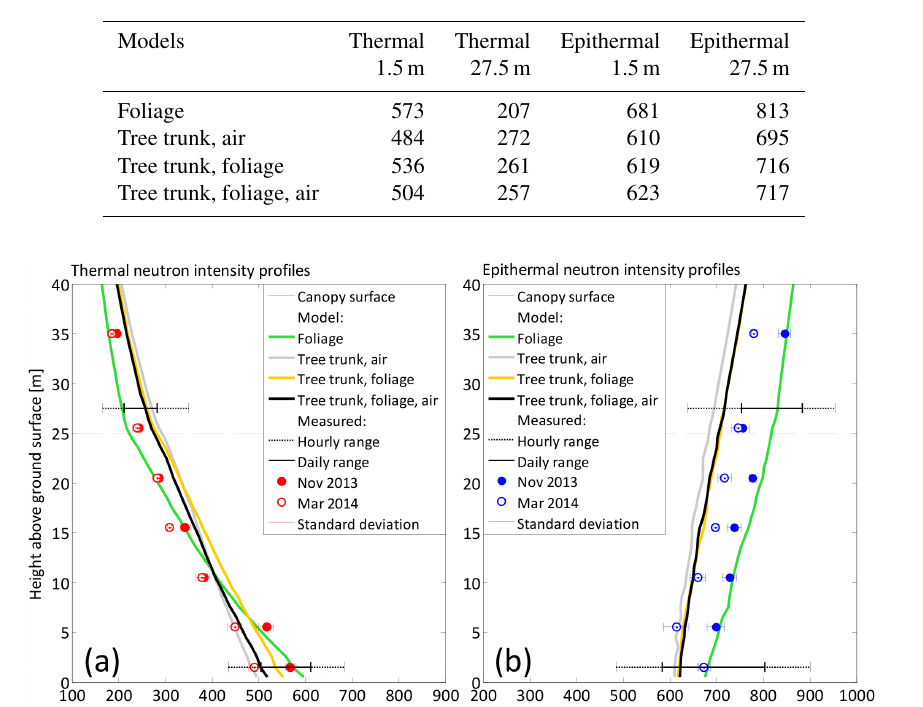
Table 5. Modeled ground level (1.5m) and canopy-level (27.5m) thermal neutron intensity and epithermal neutron intensity for the Gludsted plantation models including four different forest canopy conceptualizations (see Fig. 3).